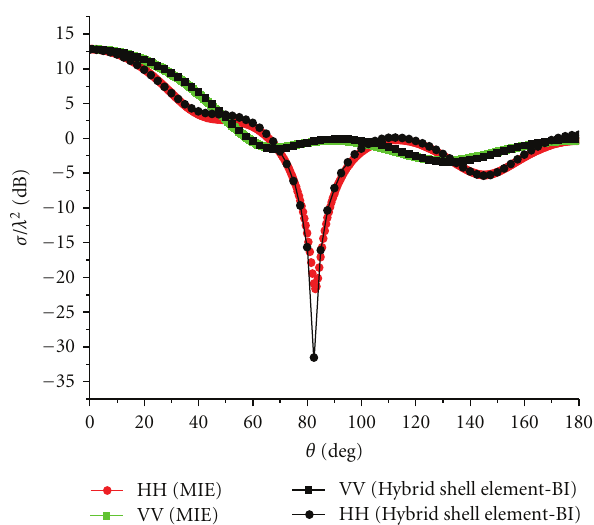
Figure 10: The bistatic RCS of the conducting sphere coated by three-thin-layer